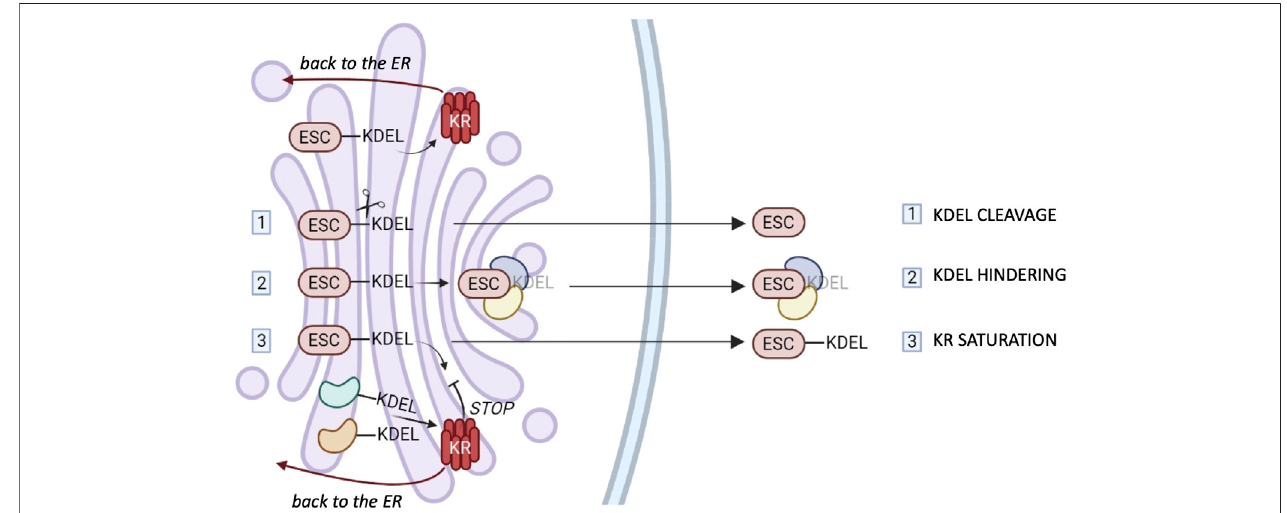
FIGURE 2 | ESCape mechanisms. Most ER chaperones and enzymes are characterized by the presence of a C-terminal motif KDEL or variants thereof which mediatestheir retrieval tothe ERviabinding toone ofthethree KDEL receptors (KR).Thecartoonsummarizespossible mechanisms thattheseproteinsmight exploit to elude KRs ’ surveillance. 1) Selective secretion by cleavage of the KDEL retention motifs. 2) Selective secretion upon binding of bulky clients that hinder KDEL-motifs. 3) Release upon weak KR retrieval activity due to client overload and/or Golgi basi fi cation. The different tissue distribution or preferential saturation/inhibition of individual KRs might sustain the selective secretion of chaperones or groups of them (see text for references).